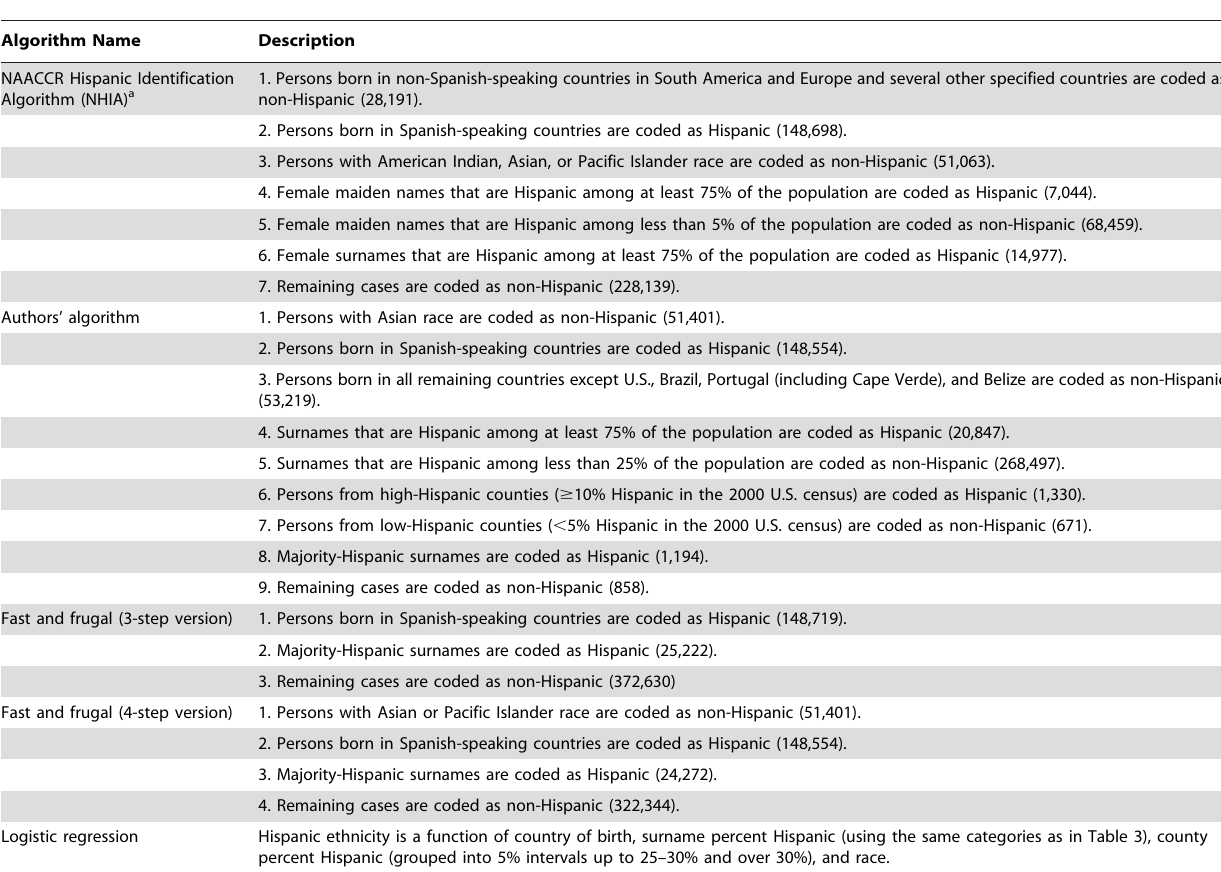
Table 1. Hispanic identification algorithms evaluated. Number of persons classified by each step given in